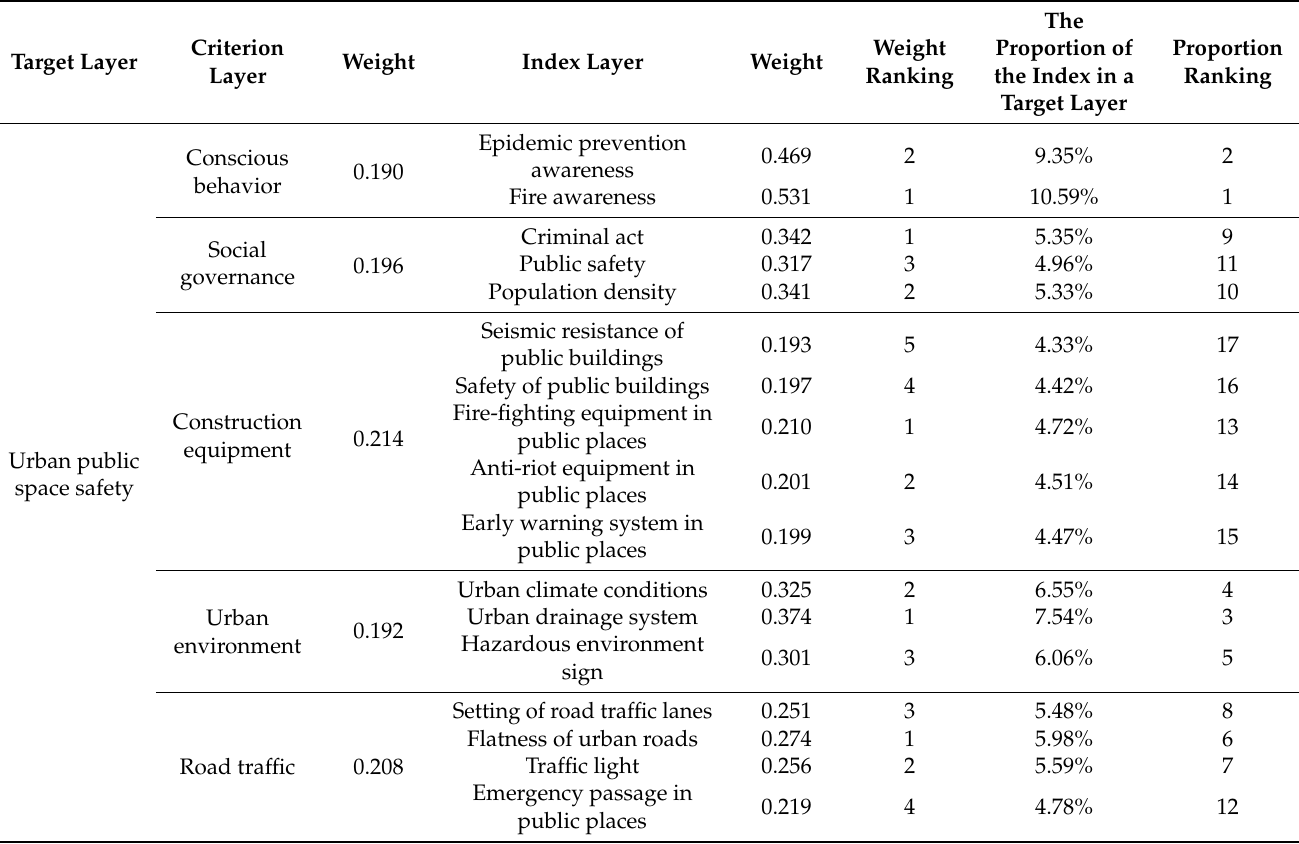
Table 10. The weight and ranking of